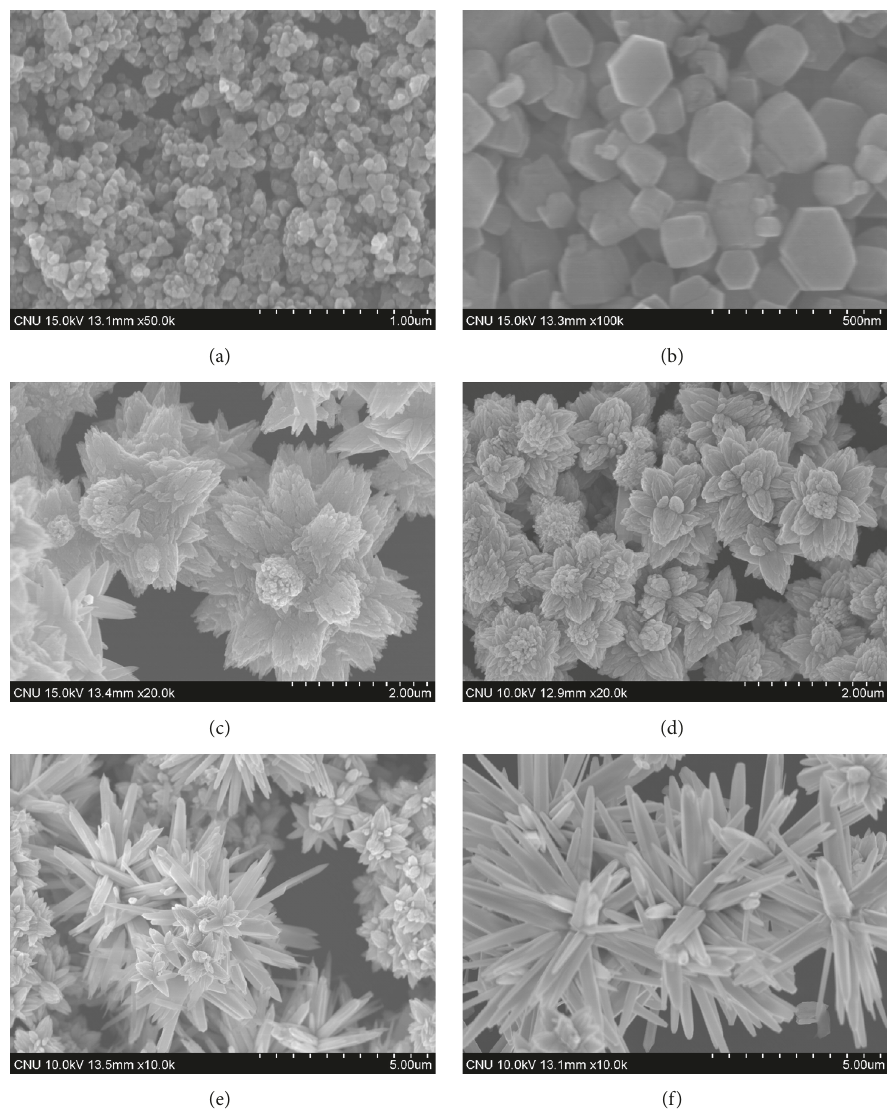
Figure 1: Typical FESEM images of ZnO nanostructures grown with different NH 4 OH concentrations of (a) 0.1 ml, (b) 0.5 ml, (c) 1.0ml, (d) 2.0 ml, (e) 2.5 ml, and (f) 3.0 ml and growth temperature and growth time of 150 ∘ C and 10 hours,